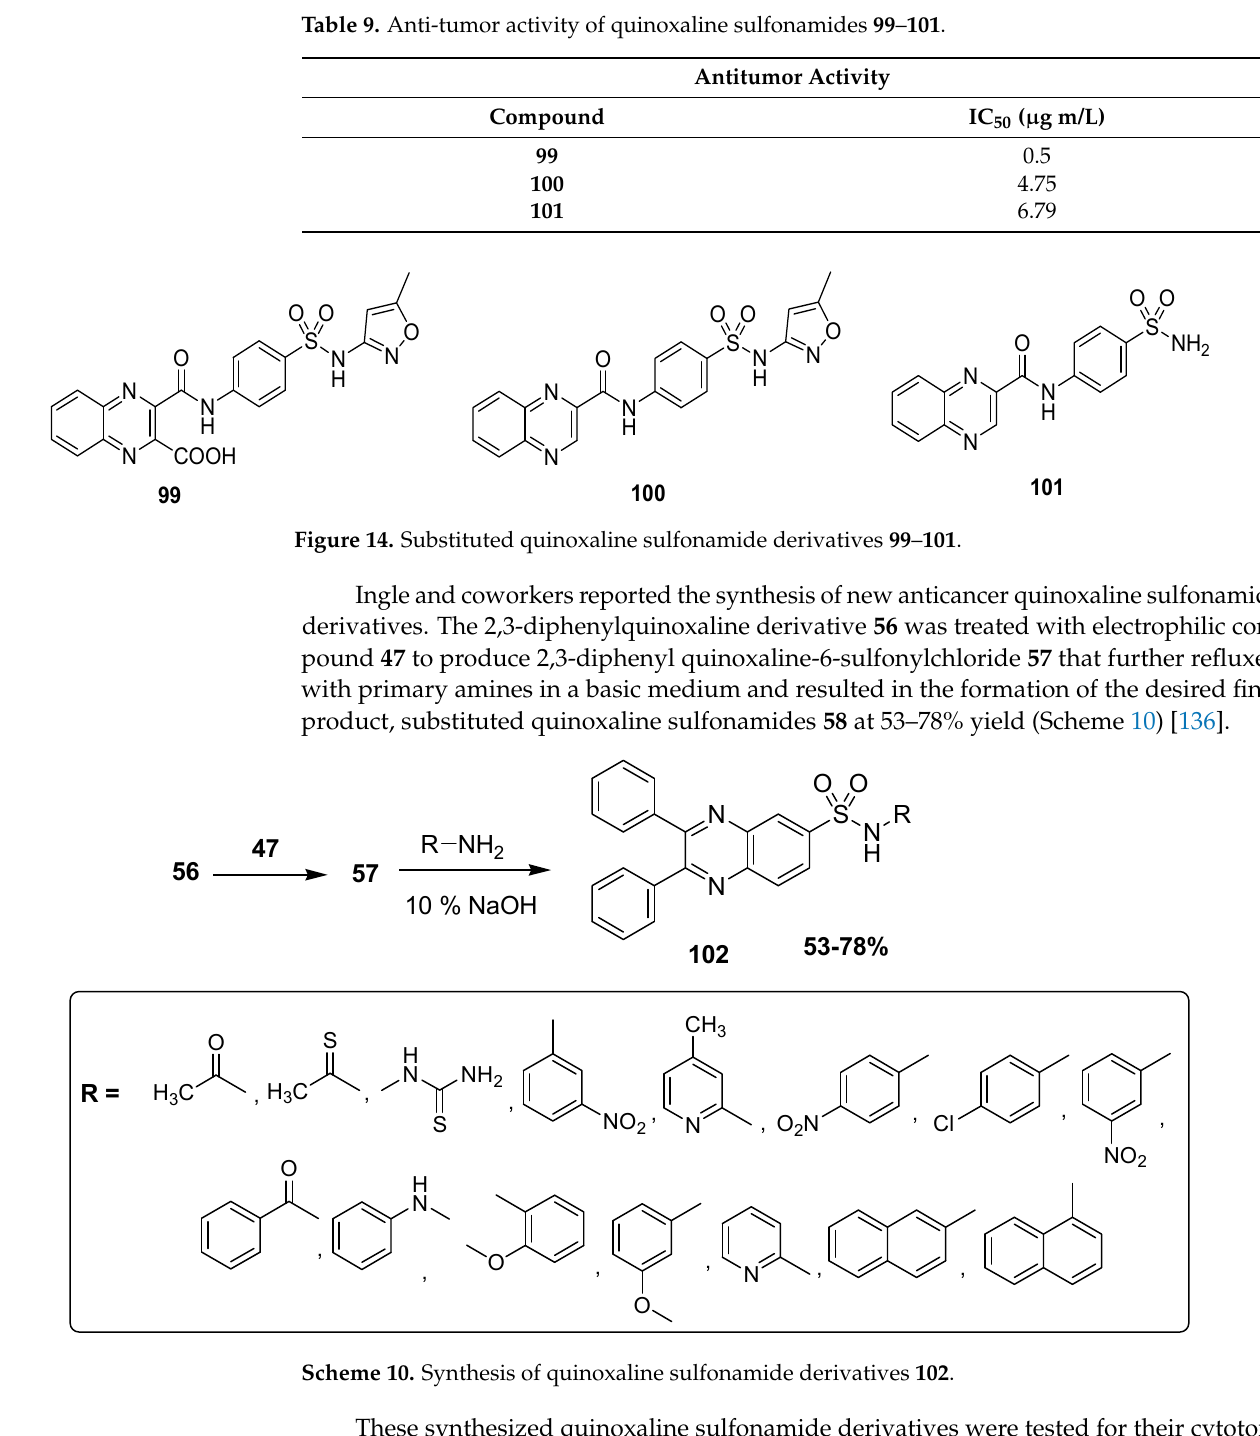
activities against various above mentioned cancer cell lines [136].